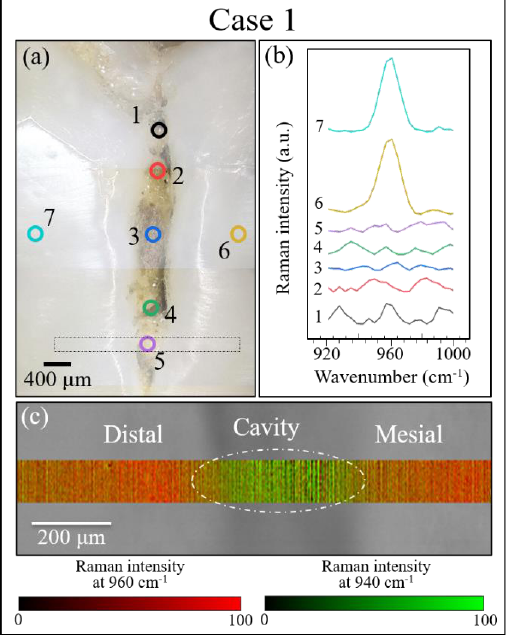
Figure 8. Raman analysis of the tooth sample in Case 1: ( a ) optical image (100× lens) showing locations (1~7) selected for point analysis, ( b ) recorded Raman spectra (10× lens) at the selected locations (cf. labels) in the spectral region around 960 cm −1 , and ( c ) Raman map corresponding to the area indicated by the rectangular inset in ( a ).